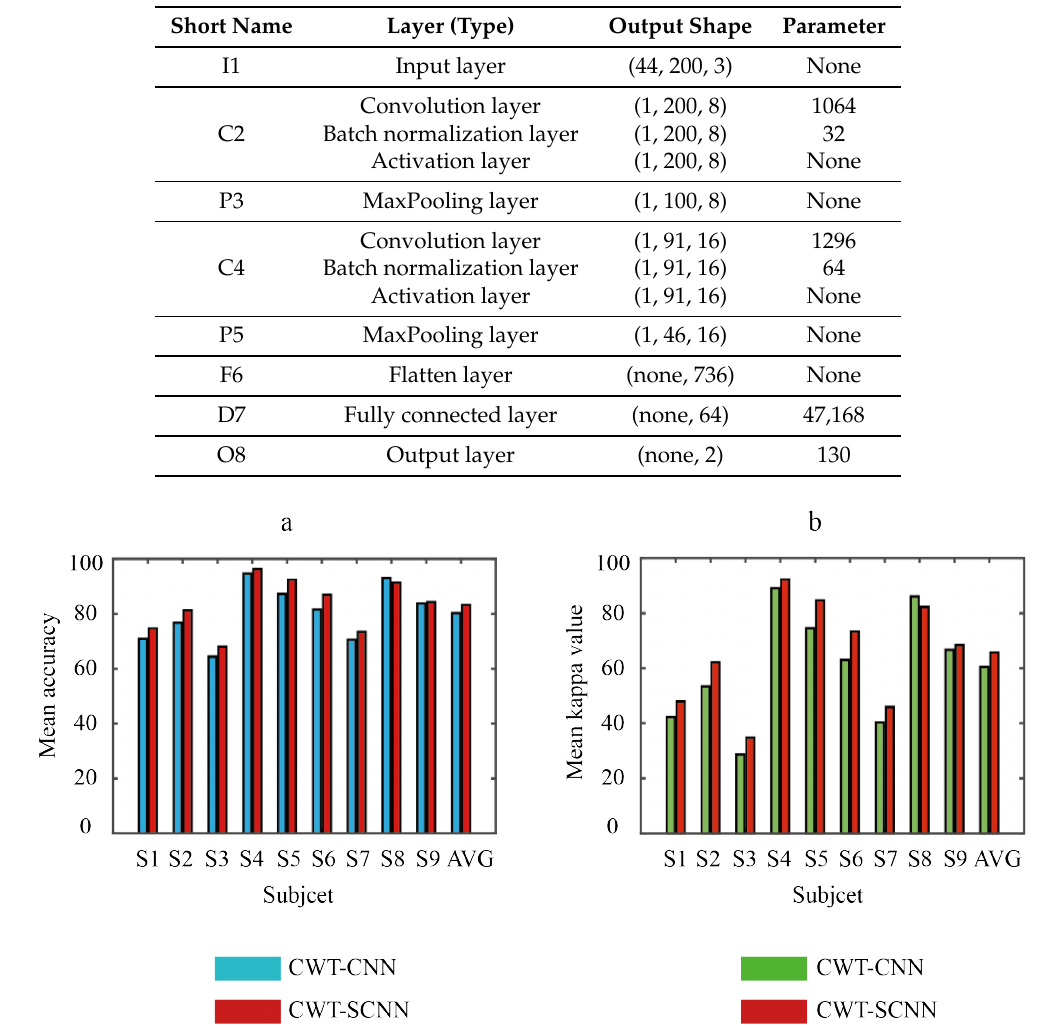
Figure 5. The mean classification accuracies and mean kappa values of the CWT-SCNN and CWT-CNN methods are shown in ( a , b ),